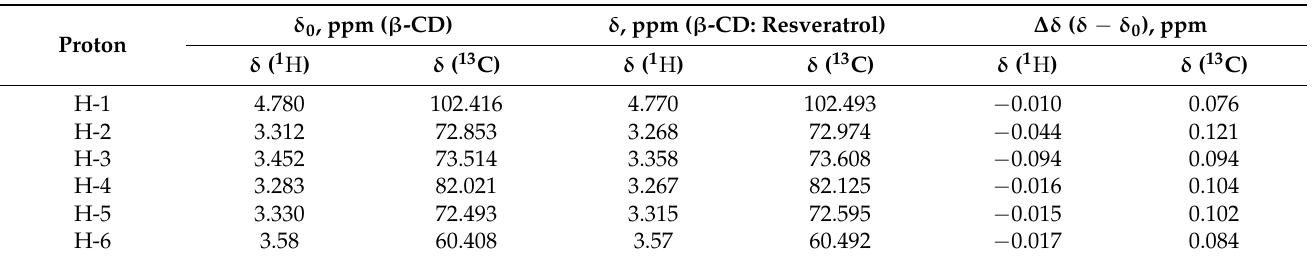
Table 4. 1 Н and 13 C NMR chemical shift values for β -CD in the absence and the presence of β -CD (molar ratio 2:1).